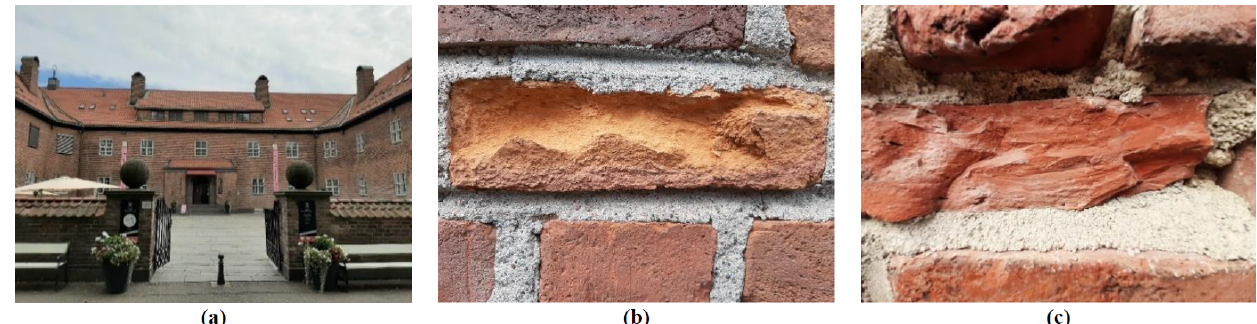
Figure 2. The (a) Haugar Art Museum and degraded bricks on its masonry fence with (b) southeast and (c) southwest